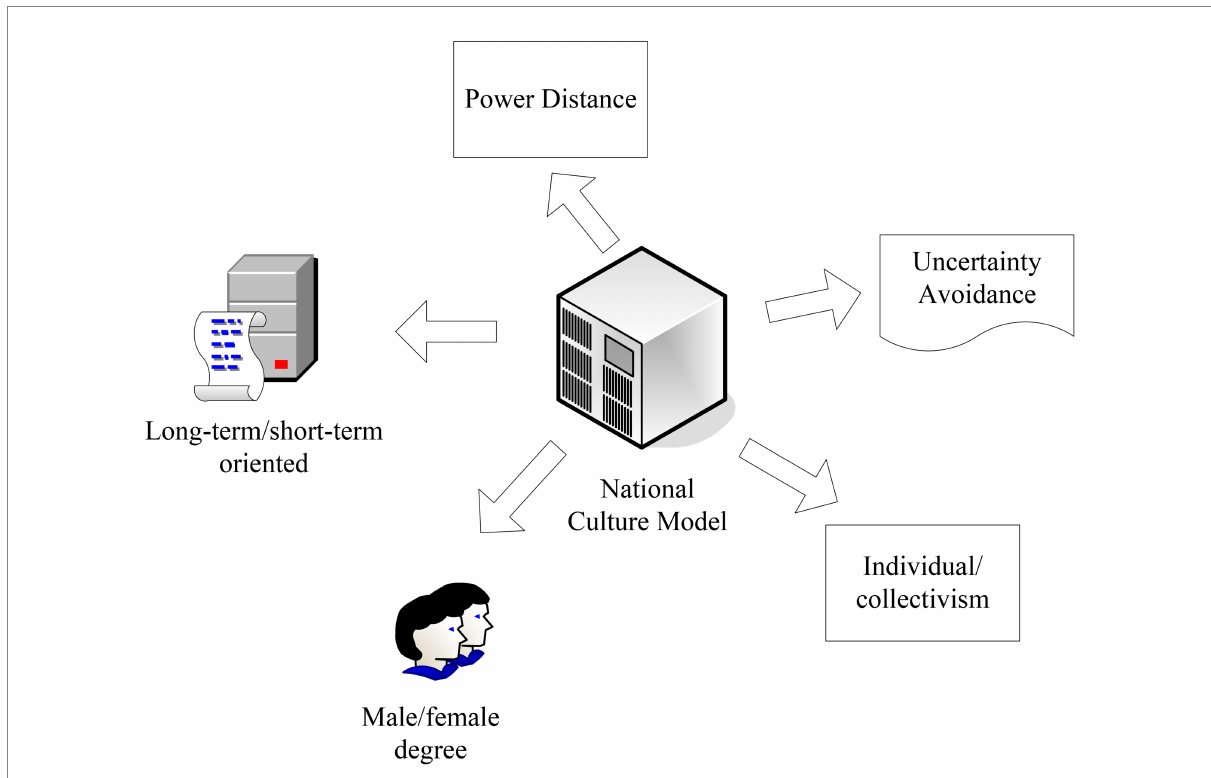
FIGURE 3 National culture